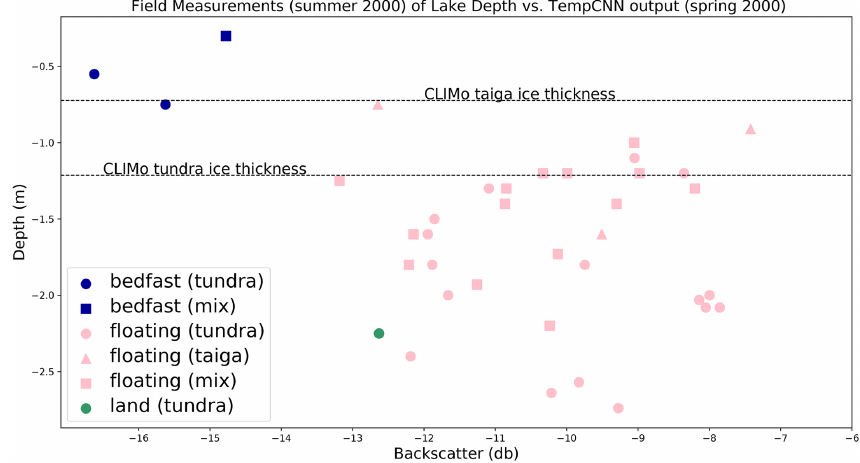
Figure 8. Matching TempCNN output with lake depths collected in 2000. Horizontal lines indicate CLIMo ice thickness predictions for taiga (0.72m) and tundra (1.21m) environments. RADARSAT-1 SAR 1999/2000 time series were used for ice regime classification. The color of points corresponds to labels assigned to each location by the TempCNN: dark blue – bedfast ice; pink – floating ice; green – land. The shape corresponds to the surrounding vegetation: circle – tundra; triangle – taiga; square – mixed; these are assigned based on the OCF vegetation map created by Turner et al.